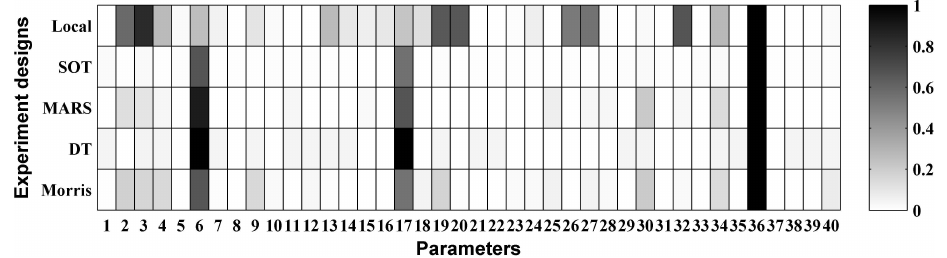
Fig. 8. The qualitative sensitivity analysis results of different methods for upward longwave radiation. The sensitivity scores are normalized to [0, 1]; 1 means most sensitive and 0 means least sensitive.